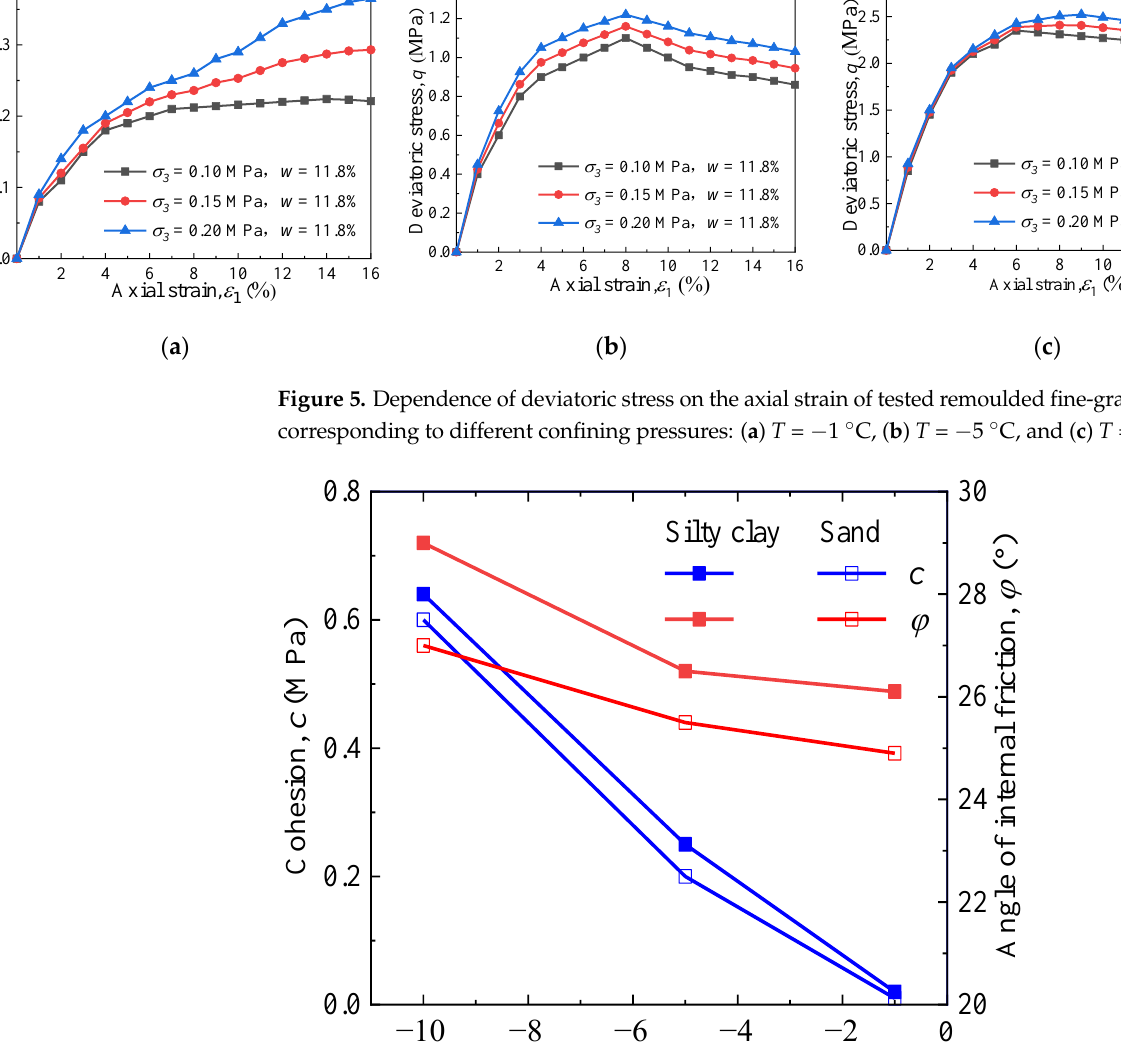
Figure 6. Variation in the cohesion and angle of internal friction versus freezing temperature.